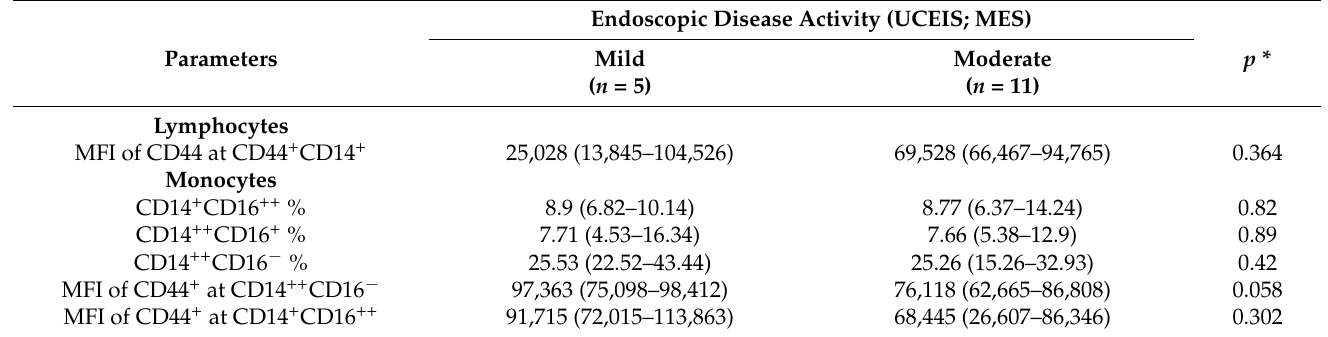
Table 3. Comparison of selected parameters between different disease activity categories in ulcerative colitis